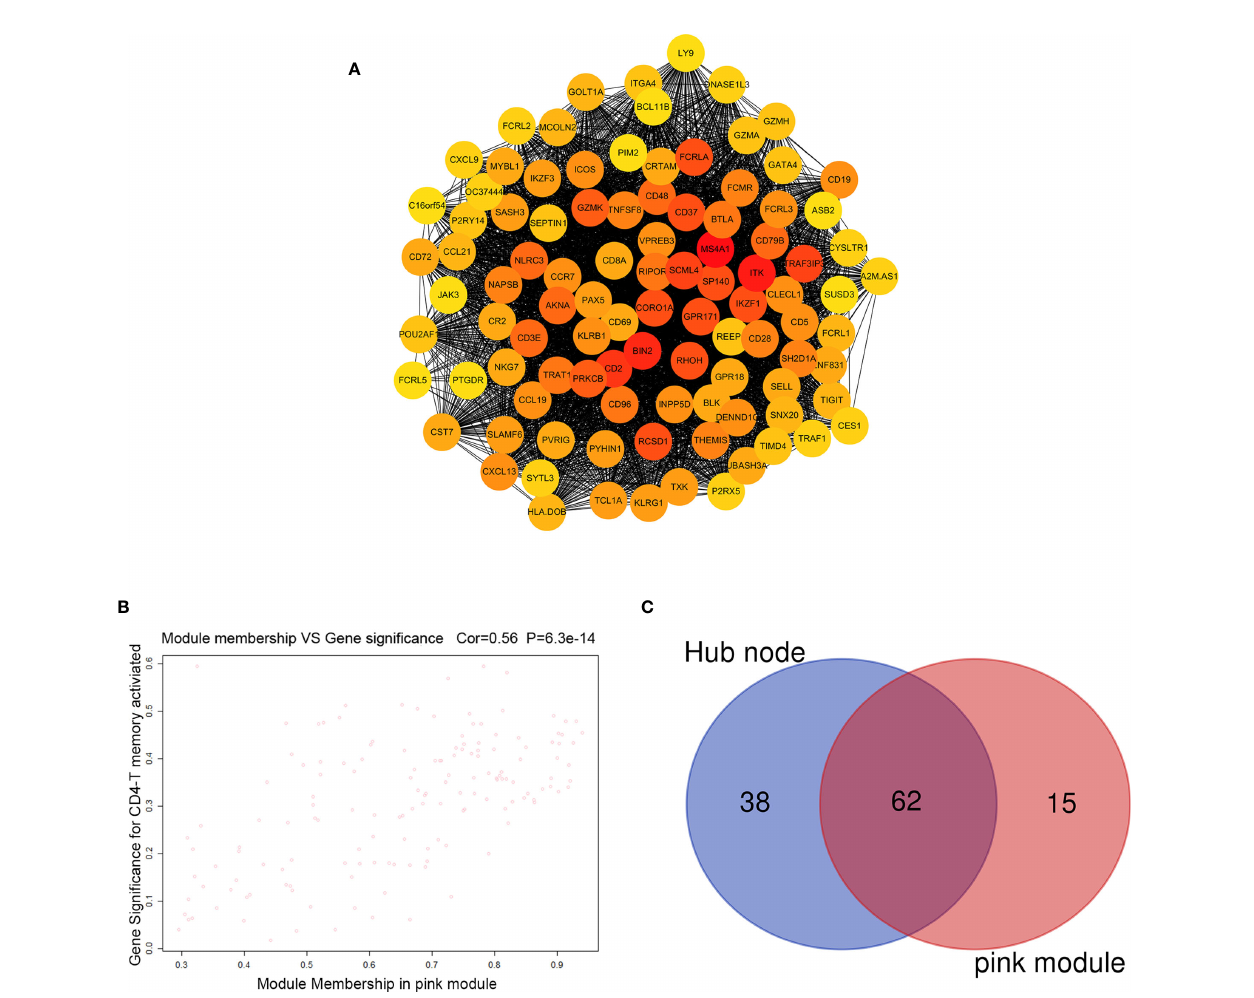
FIGURE 4 | Identi fi cation of hub genes. (A) PPI network of top 100 genes was selected from the pink module. (B) A scatter plot of the genes in the pink module. (C) Hub genes were selected according to the overlap between PPI and pink module in co-expression